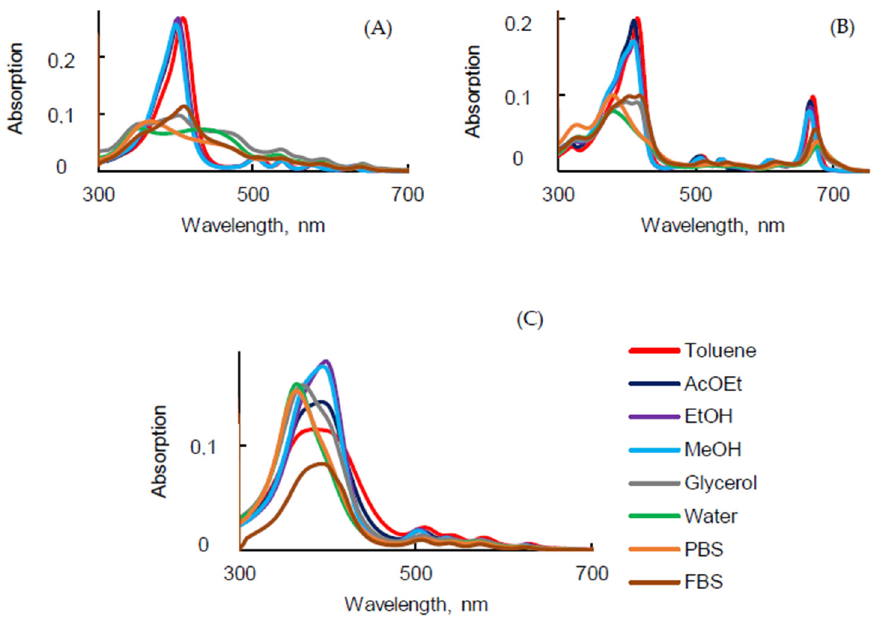
Figure 2. UV-visible absorption spectra of PpIX ( A ), PPa ( B ) and PF ( C ) in different solvents ( c = 1.87 µ M).